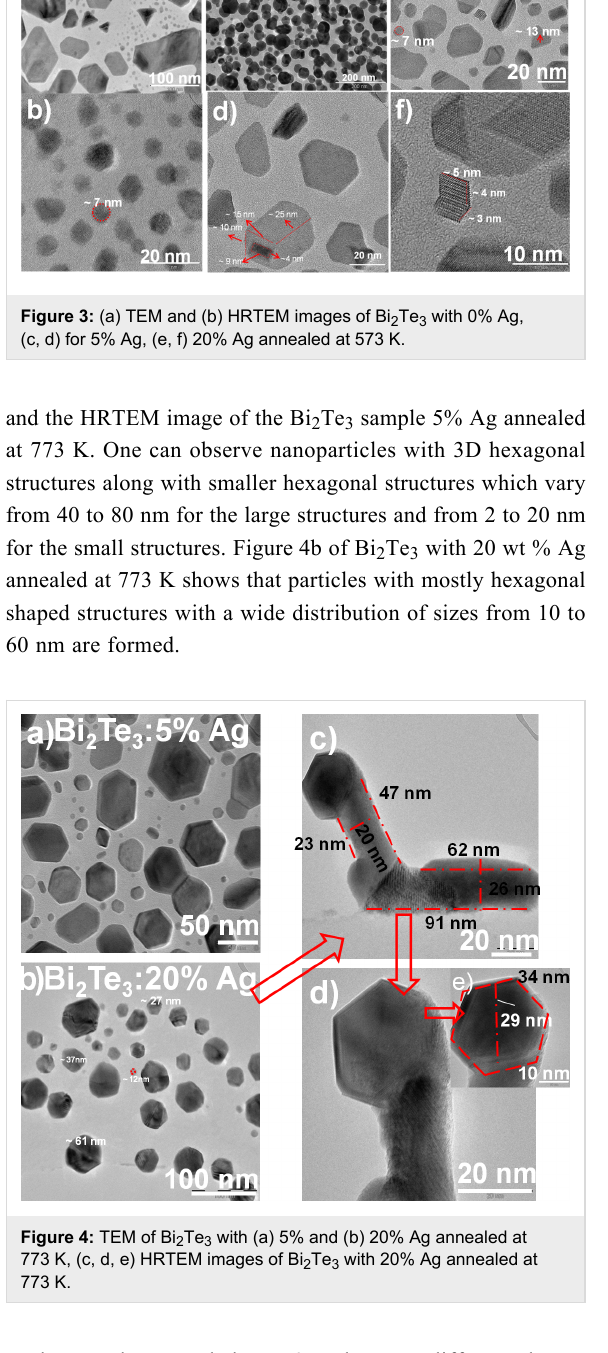
Figure 5: Electrical conductivity ( σ ) of (a) Bi 2 Te 3 with (0, 2, 5, 10, 15 and 20%) Ag annealed at 573 K as a function of the temperature; (b) comparison of samples (0, 5, 20%) Ag annealed at 573 K with (5, 20%) Ag annealed at 773